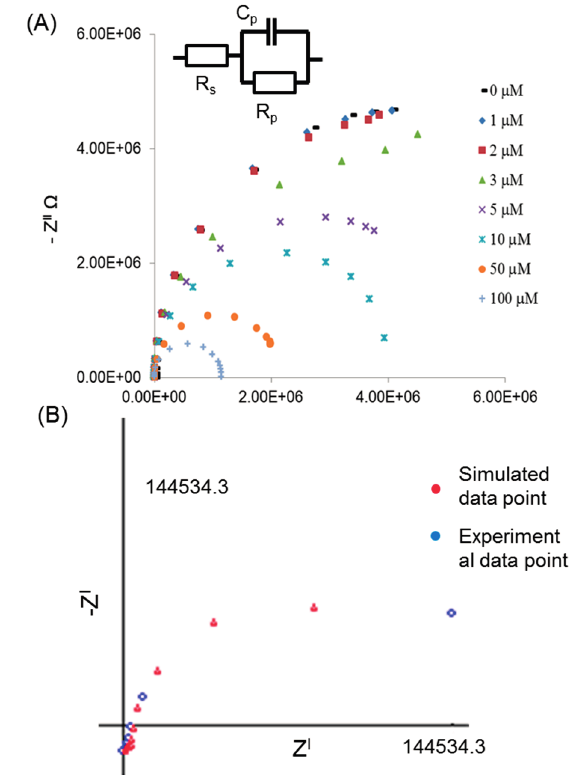
Figure 3. ( A ) Nyquist plots obtained for NPA at constant pore diameters (45 nm) of with various different concentrations of NaCl ( B ) experimental data is showing the agreement against the simulated data with use of equivalent